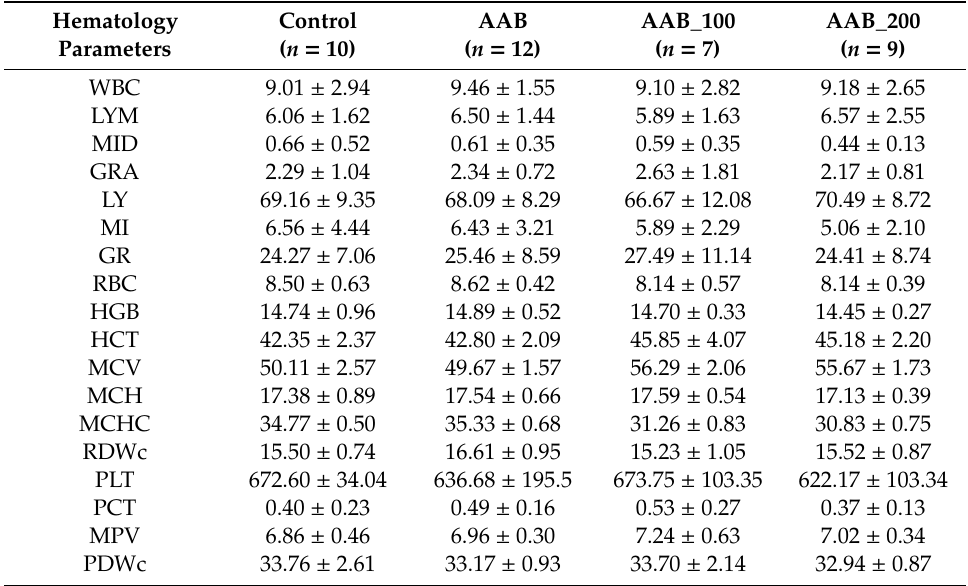
Table 2. E ff ects of LBPs on hematology parameters.